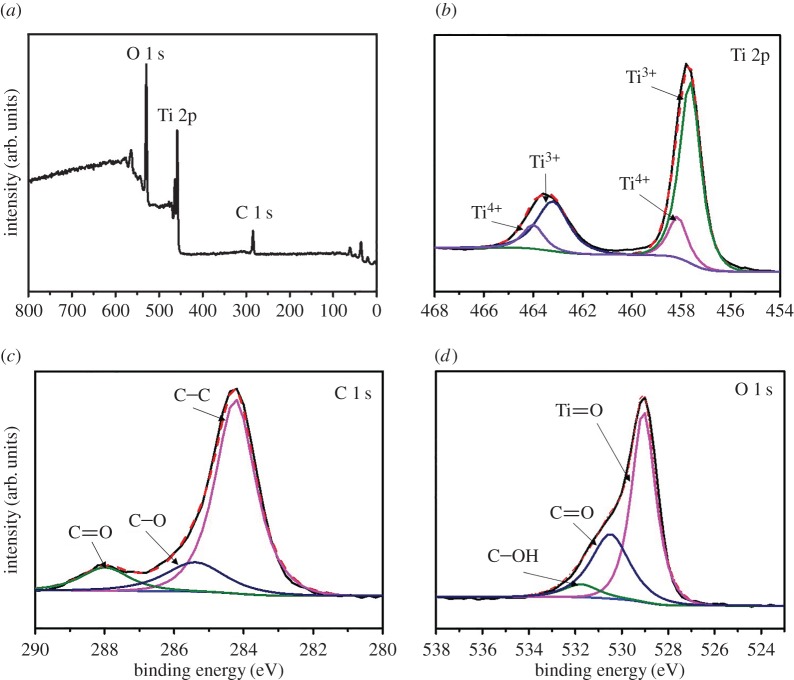
XPS spectra of CQDs/TiO2 NWs. (a) Full survey. (b) Ti 2p spectra. (c) C 1 s spectra. (d) O 1 s spectra.